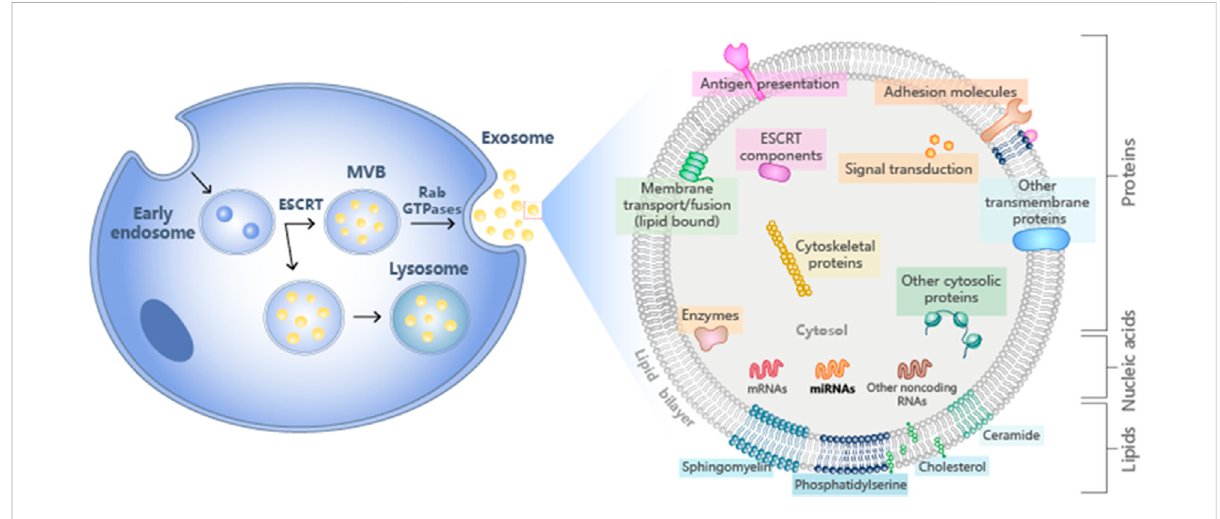
FIGURE 1 Schematic diagram of the composition of